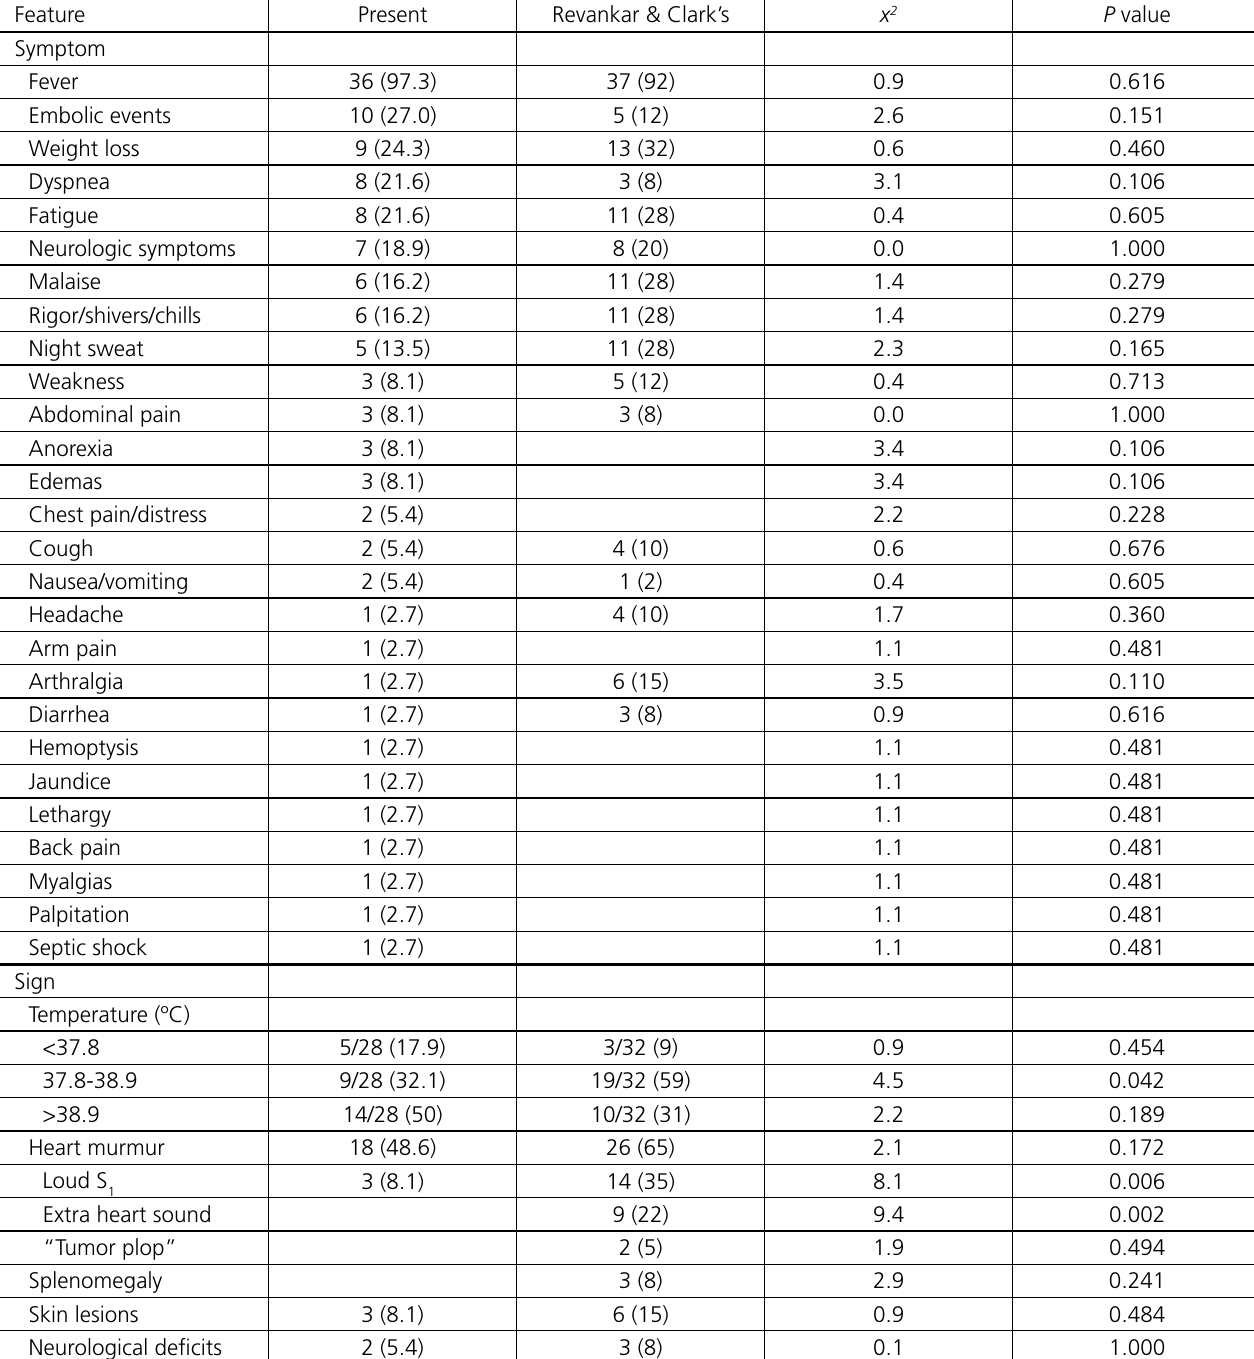
Table 3. Onset symptoms and signs of the patients with infected cardiac myxoma.